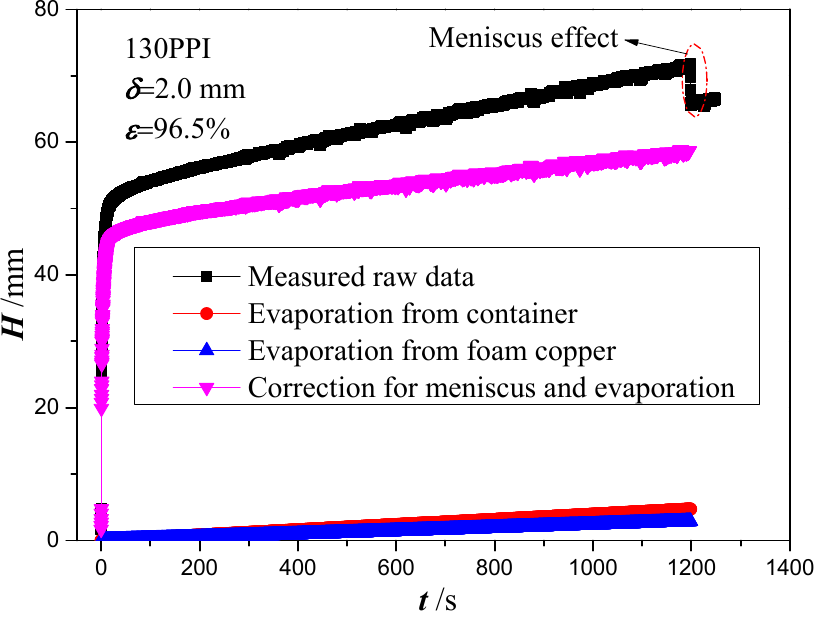
Figure 6. Raw data correction due to evaporation and meniscus effects.